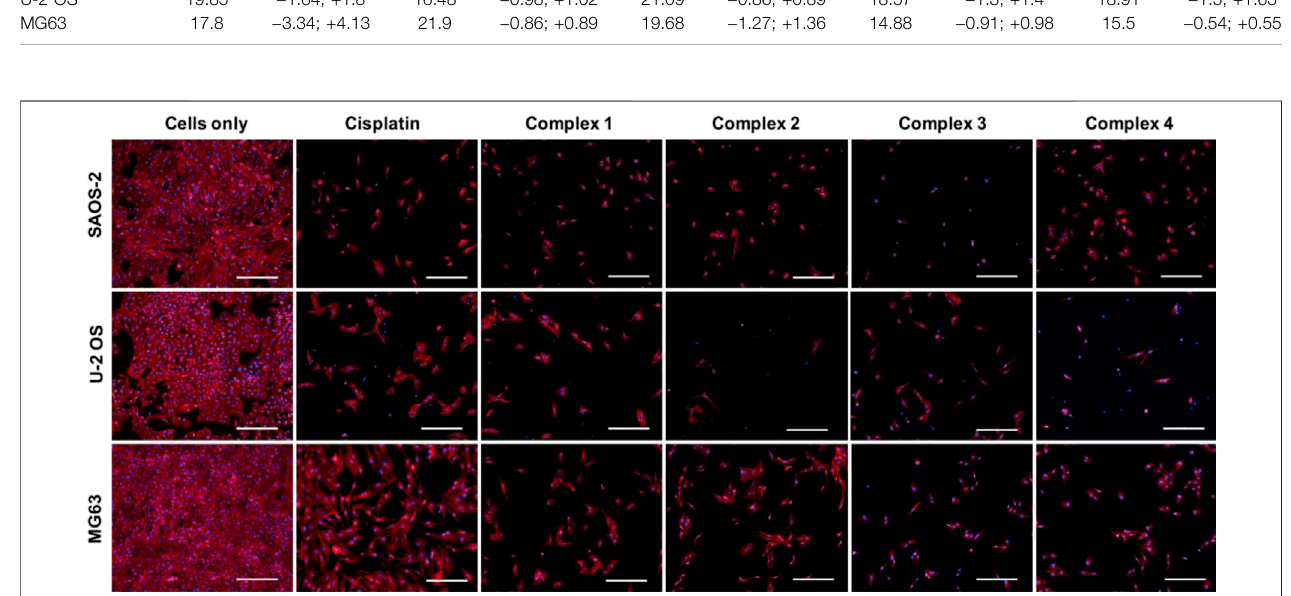
FIGURE4| CellmorphologyevaluationonSAOS-2,U-2OS,andMG63.ActinandDAPIstainingofosteosarcomacelllinestreatedwithandwithoutdrugs(30 µM) for 72 h. F-actin fi laments in red; cell nuclei in blue. Scale bars 200 µm.